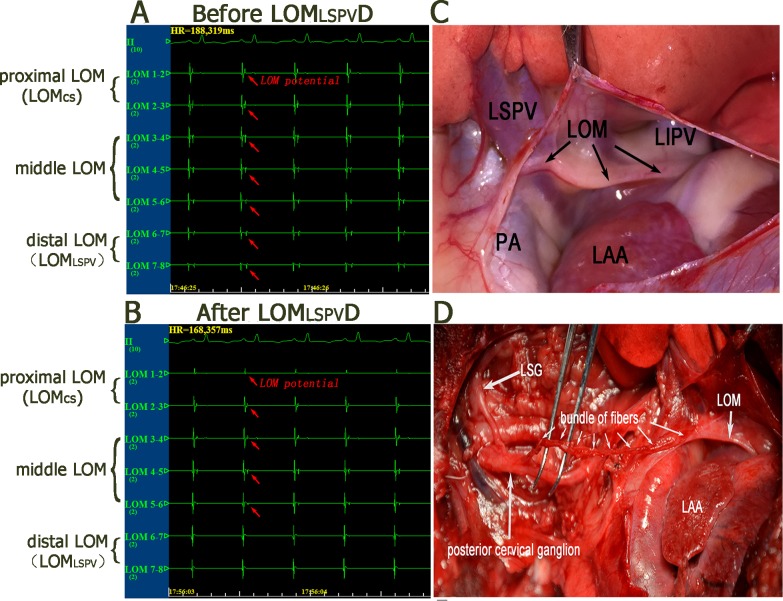
The potential and anatomy position of LOM.(A) The potential of LOM from its proximal to its distal portion. (B) The potential of the distal portion of the LOM dismissed. (C) The LOM originates from the coronary sinus and ends in the pericardium near the LSPV. (D) The LSG sends out a cluster of fibers that end in the posterior cervical ganglion, which sends out a bundle of fibers that innervate the distal part of the LOM. LOM: the ligament of Marshall; LSPV, LIPV: left superior, left inferior pulmonary vein; PA: pulmonary artery; LAA: left atrial appendage.